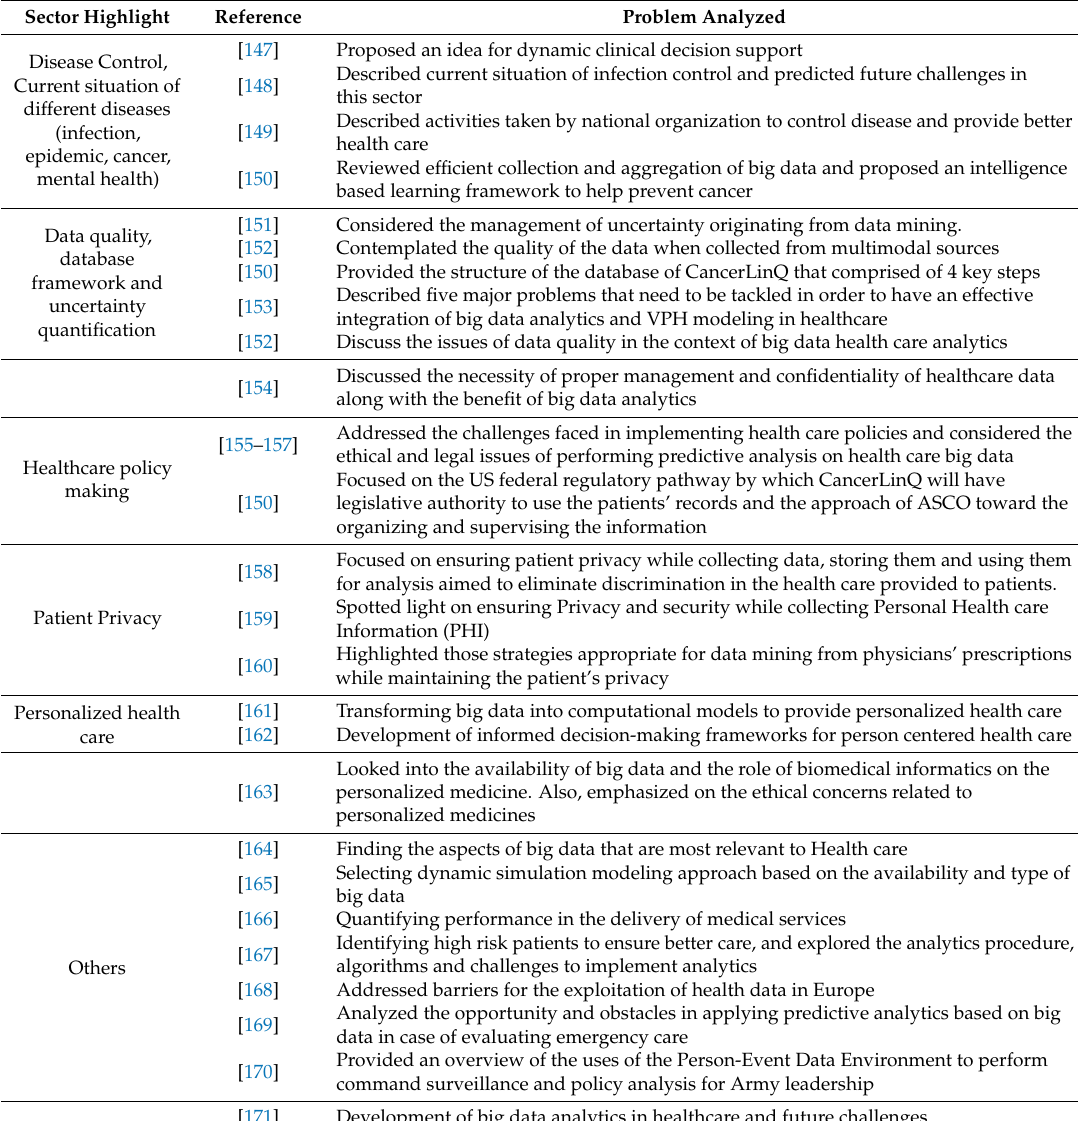
Table 11. Problem analyzed in theoretical